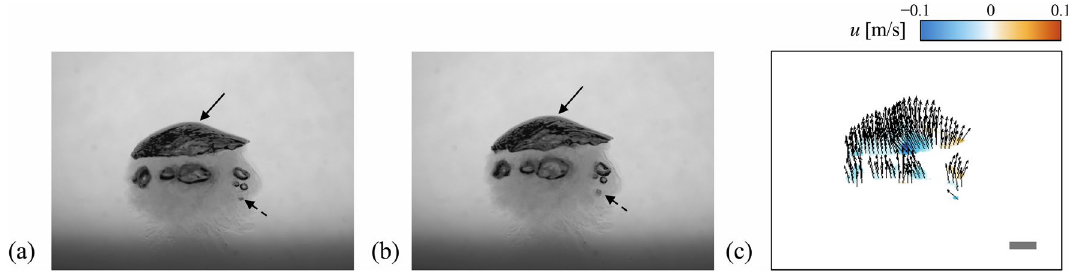
Figure 11. ( a,b ) Consecutive images (with a time separation of 2.5 ms) of the cap bubble and a few smaller bubbles. ( c ) Corresponding velocity field obtained by the fine-tuned CNN-based optical flow (the contour denotes the horizontal velocity). The solid bar in ( c ) denotes 10